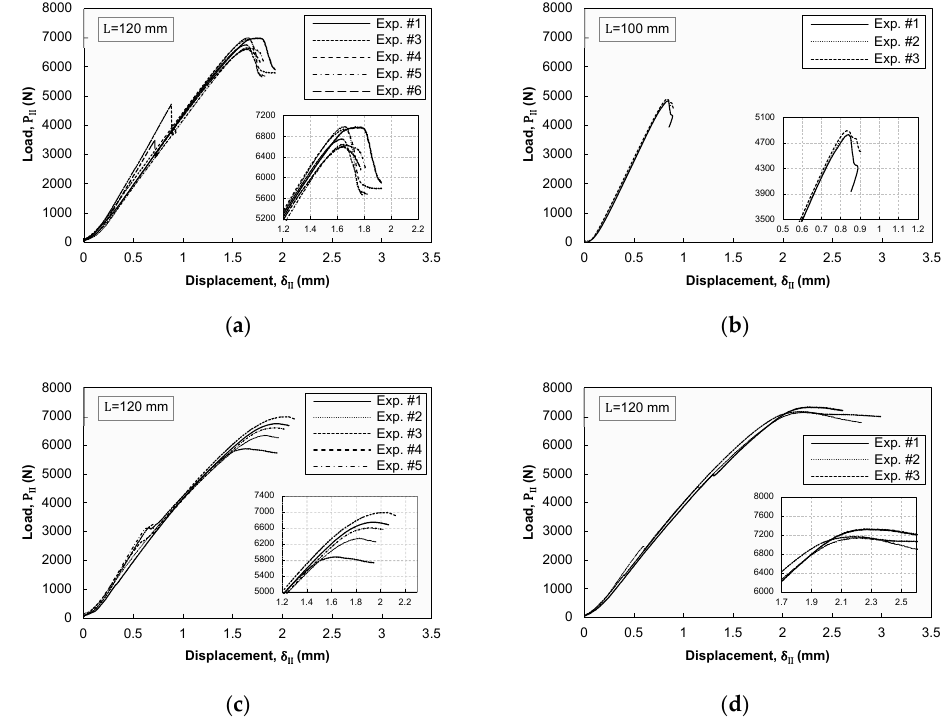
Figure 8. Load ( P II ) versus crosshead displacement ( δ II ) curves from the end-notched flexure (ENF) experiments for the four manufacturing options (MOs) under study: ( a ) MO 1, ( b ) MO 2, ( c ) MO 3, and ( d ) MO 4. L is the span length of the ENF